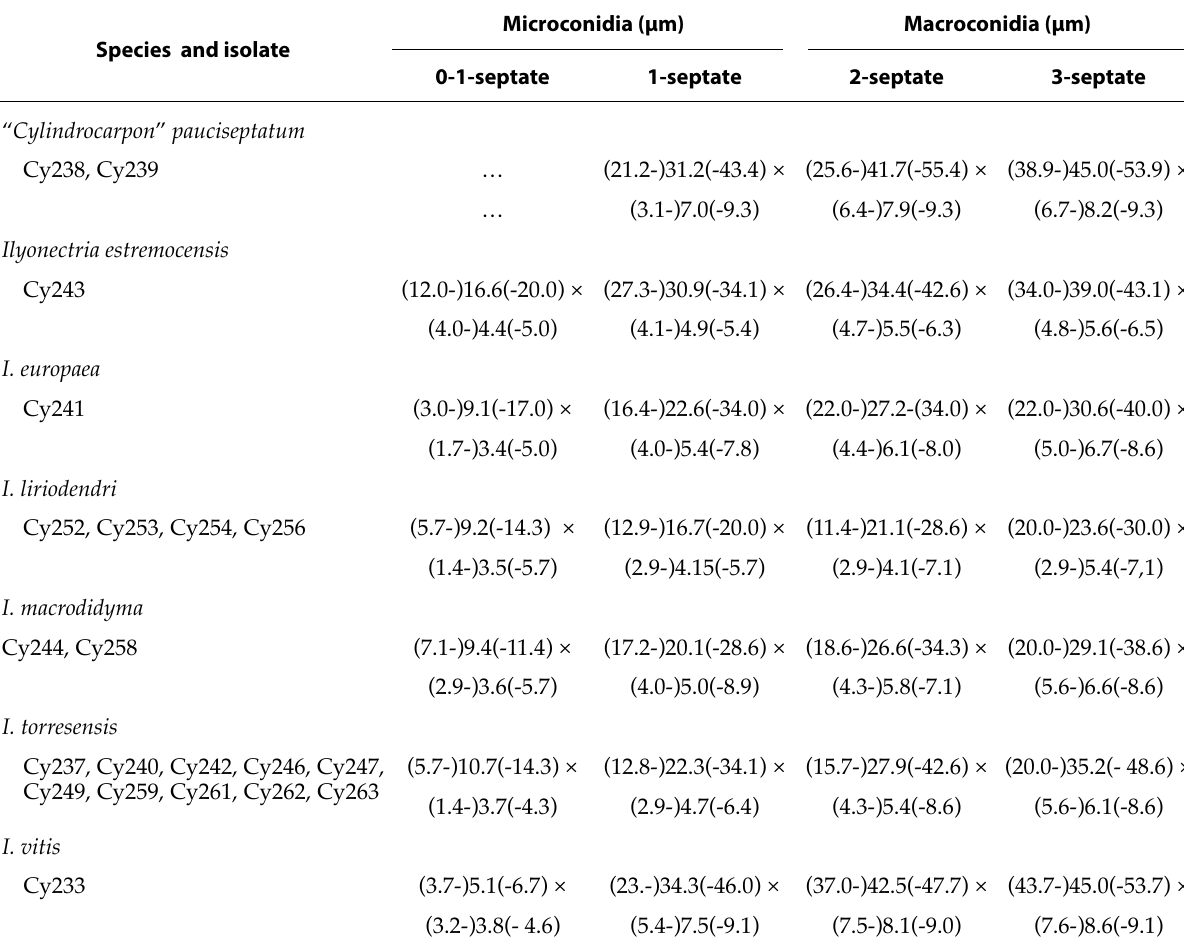
Table 3. Average conidia size for 21 isolates of Ilyonectria spp . and “ Cylindrocarpon ” pauciseptatum in SNA medium, after 20 days incubation (20°C, 12 h